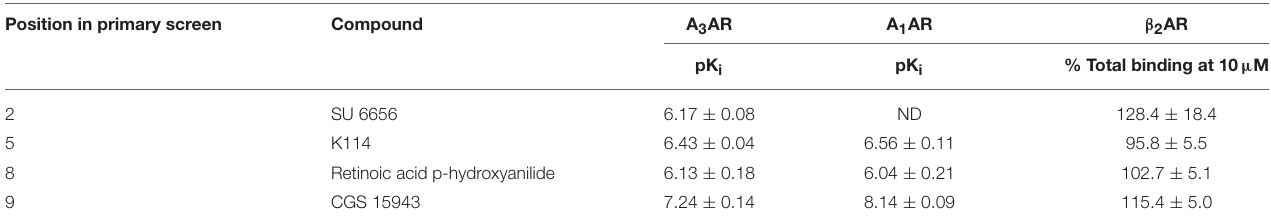
TABLE 4 | Affinity of selected hits from the LOPAC library at the A 3 AR, A 1 AR, and β 2 AR: Compounds were tested on CHO cells expressing the A 3 AR, A 1 AR, and β 2 AR in the HTS format fluorescent ligand binding assay using 25nM CA200645 as the tracer for A 3 AR and A 1 AR and 10nM of BODIPY-TMR-CGP for β 2 AR. Position in primary screen